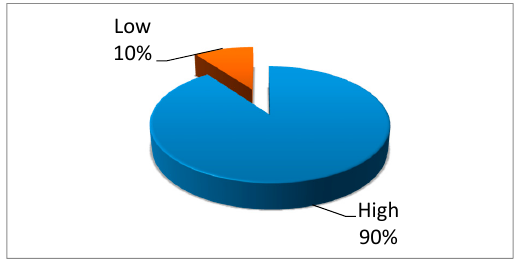
Figure 10. Expert opinions on the extent to which various problem perspectives are being addressed (“high” means that the rate at which the problem is being addressed is fast, while “low” means it is slow).